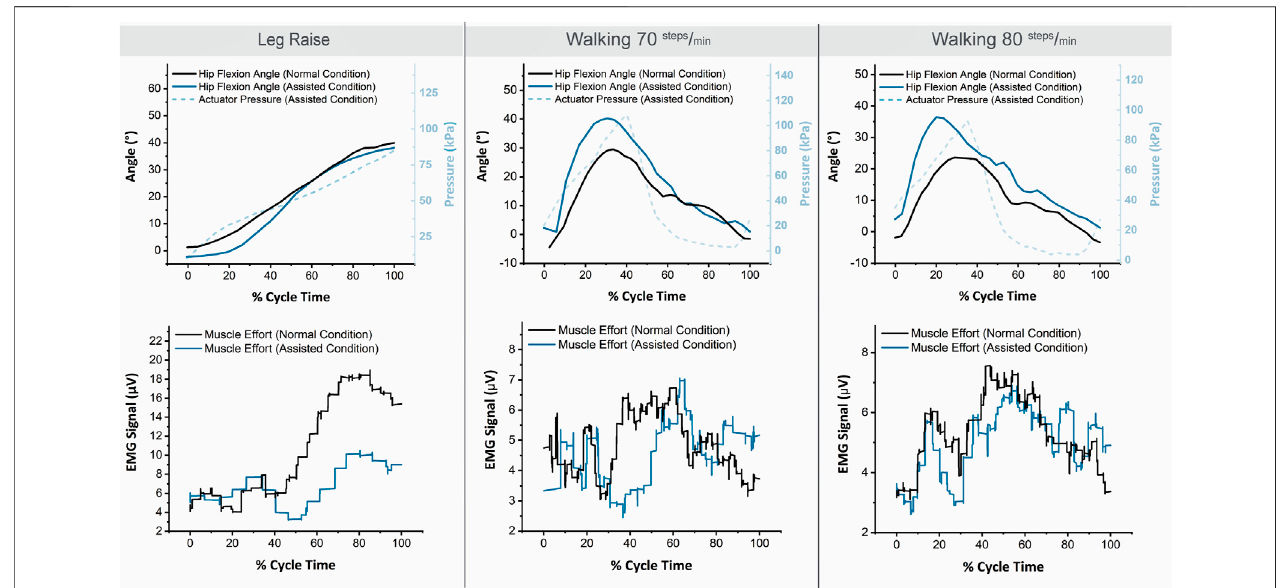
FIGURE 9 | Example IMU, pressure, and EMG trajectories for one subject (S01) for the three motions and two conditions.